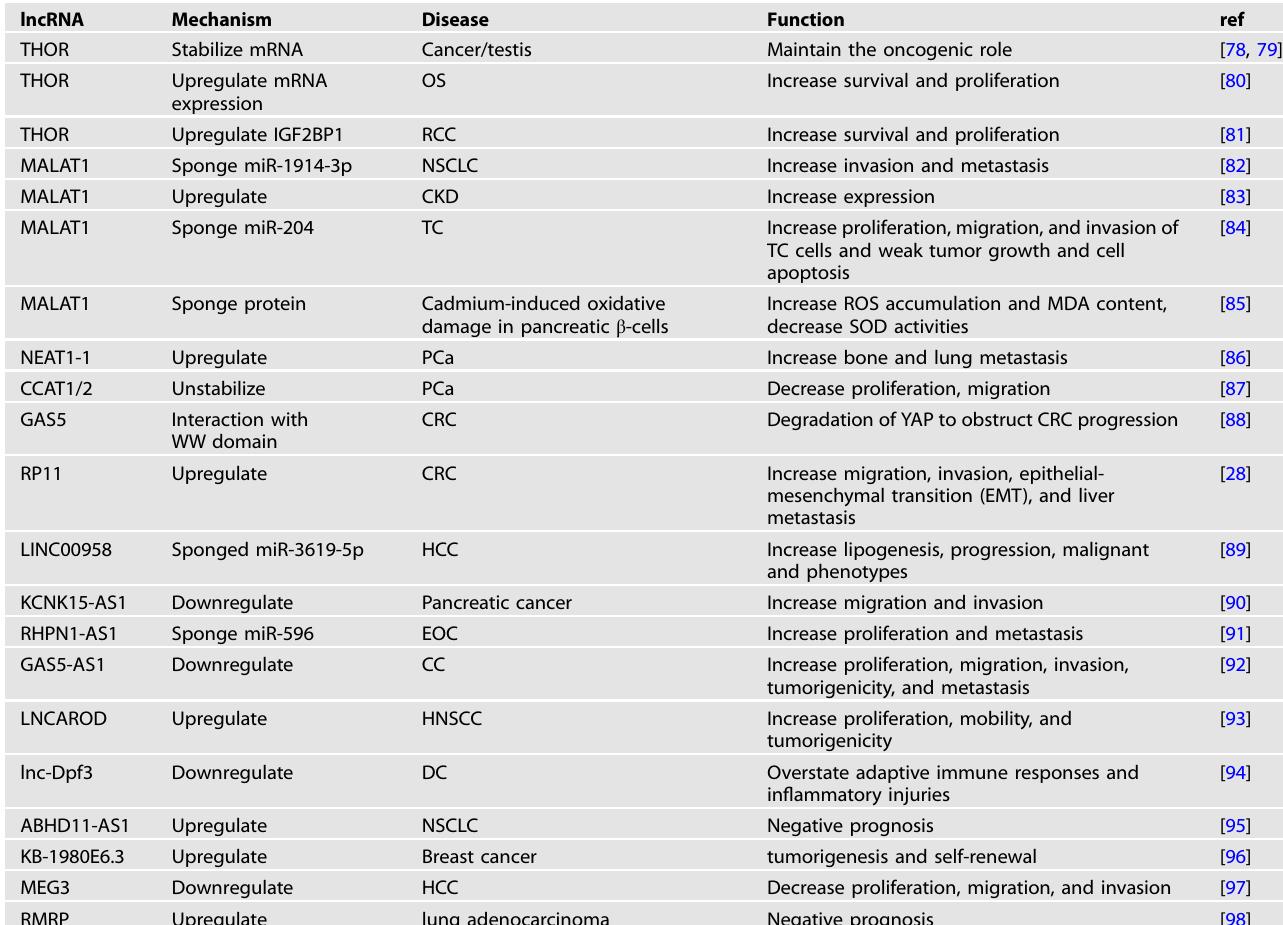
Table 1. LncRNA regulation in